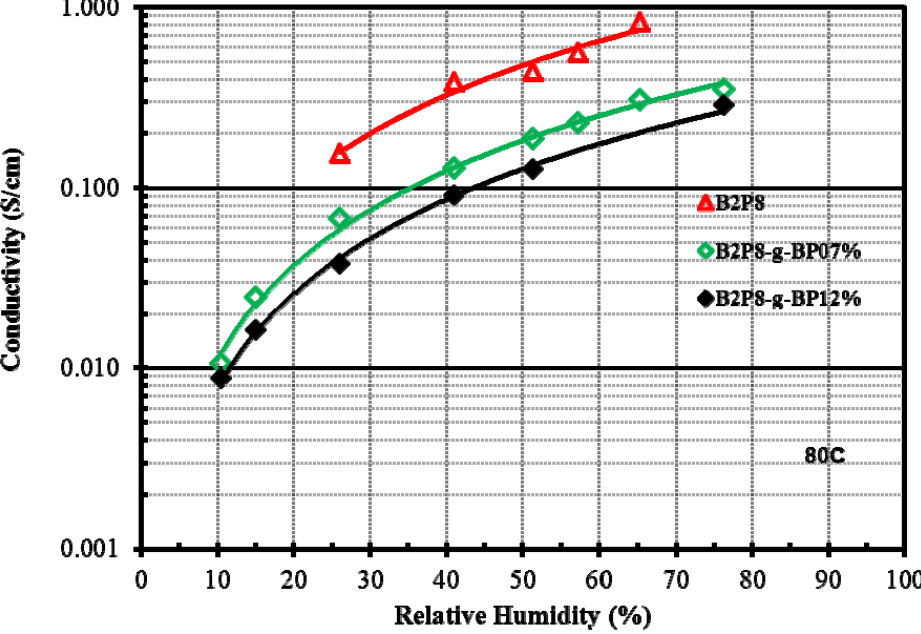
Figure 5. Conductivity as a function of RH measurements of best-in-class biphenyl-PPDSA with cross-linked polymers measured at 80 °C [32,33]. Here PPDSA is poly(phenylene disulfonic